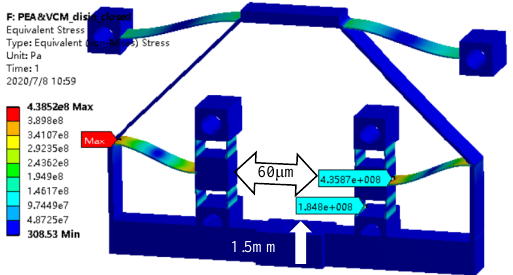
Figure 5. Stress distribution of ACPM while actuating VCM and PEA simultaneously.